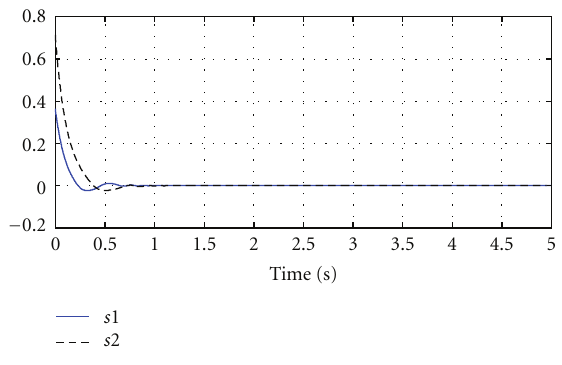
Figure 6: System states with applying the proposed method.